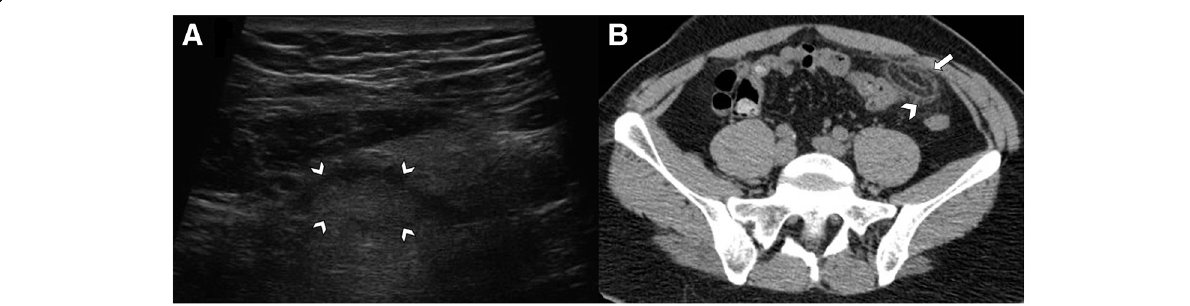
Fig. 2 Acute epiploic appendagitis in a 41-year-old man. a Ultrasound transverse scan, at the point of maximum tenderness, shows a well-defined hyperechoic ovoid fat lesion, surrounded by hypoechoic rim (arrowheads), adjacent to the anterior abdominal wall. b Axial non-contrast CT image shows an inflamed fatty ovoid lesion near the sigmoid colon with hyperattenuating ring (arrow) and nearby fat stranding